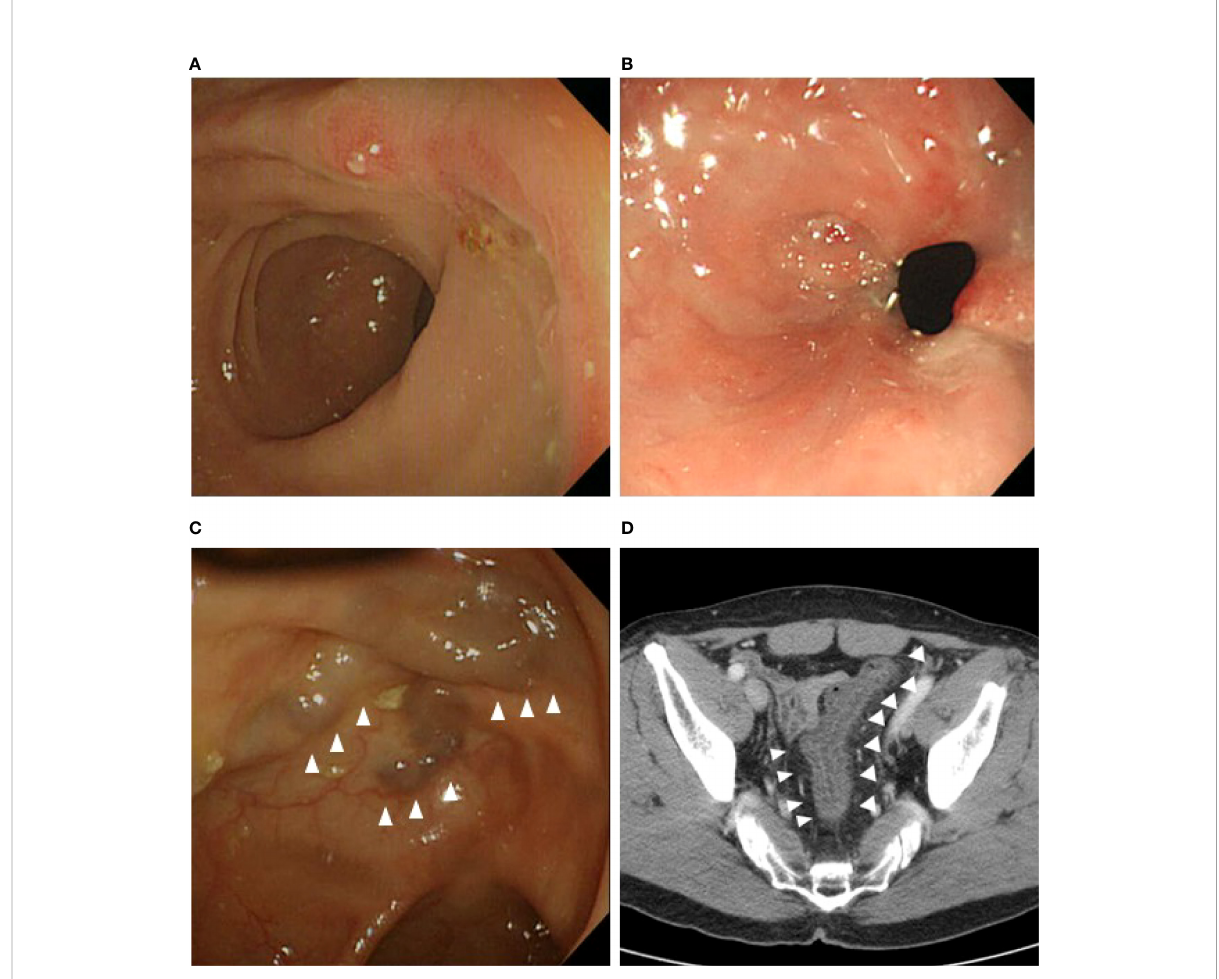
FIGURE 2 Intestinal complications on computed tomography or colonoscopy during follow-up. (A) Anastomotic ulcer. (B) Anastomotic stricture. (C) Venous engorgement at the remnant distal bowel. (D) Colitis with thickened colon wall at the remnant distal